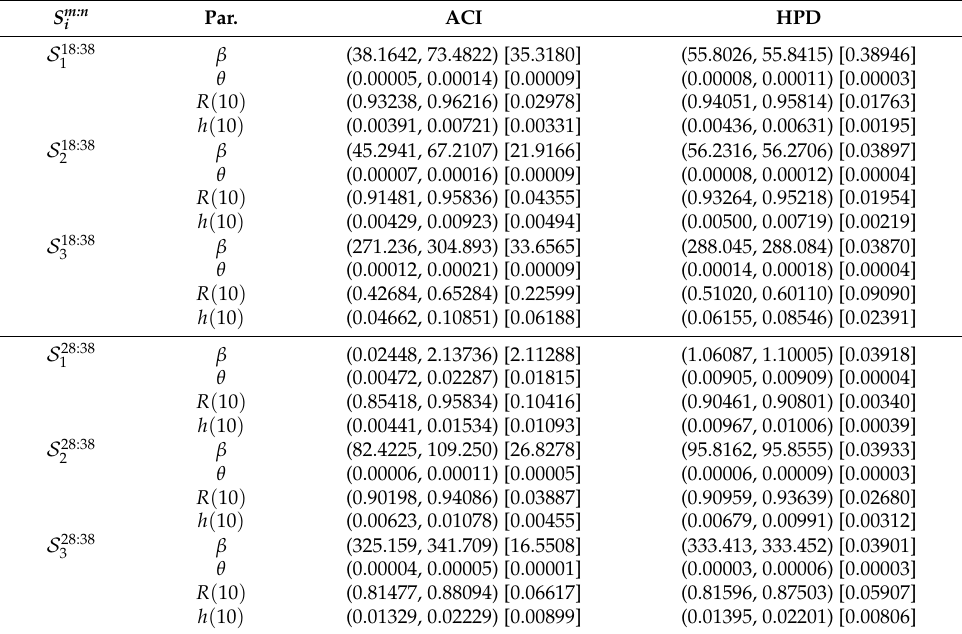
Table 3. The 95% interval estimates (ILs) of β , θ , R ( t ) , and h ( t ) under MTS